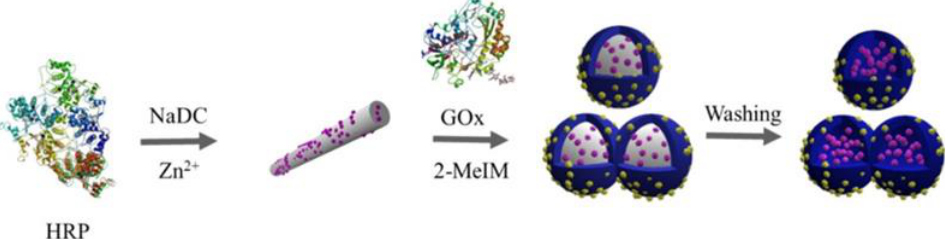
Figure 4. Fabrication of HRP@H – ZIF – 8 – GOx. Reprinted with permission from Ref. [36]. Copyright 2019, American Chemical Society.